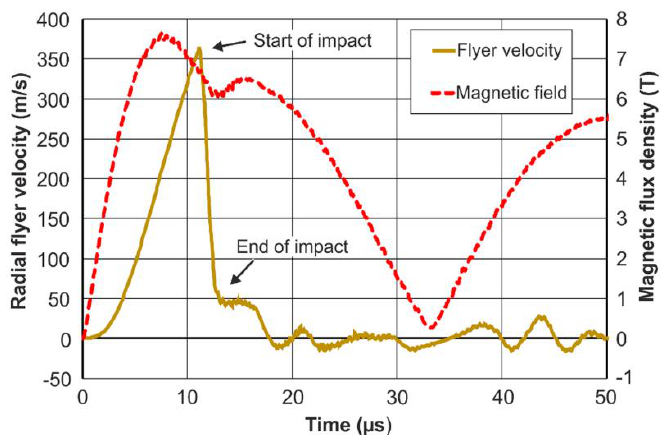
Figure 8. Radial velocity of the flyer edge and the magnetic field during the process. The magnetic field was evaluated at 0.1 mm from the field shaper edge and scaled with the mentioned factor of 0.3 for consideration of the borehole in the field shaper. The results are from the LS-DYNA simulation.